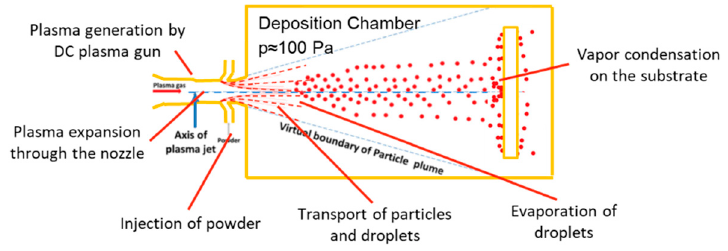
Figure 1. Principle of the PS-PVD process.